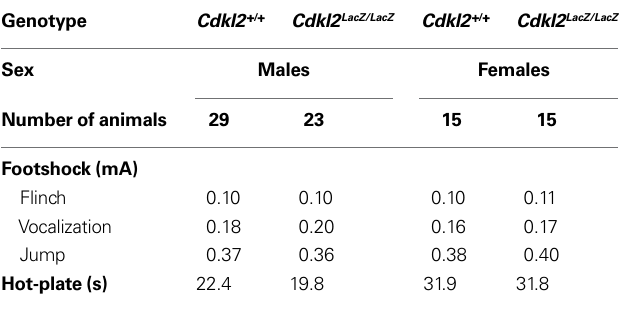
Data are expressed as the mean